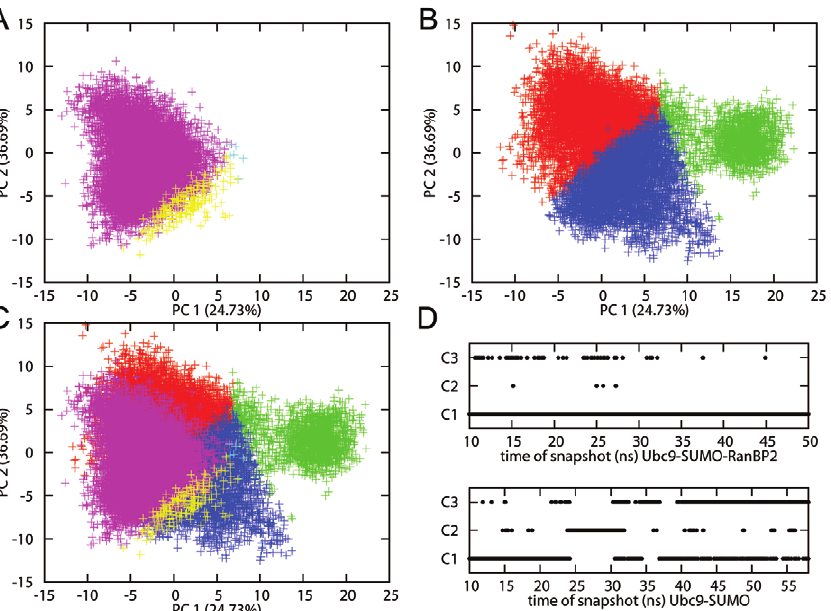
Figure 4. Projection of Ubc9 conformations on principal components. The PCs are given in A˚. The proportion of all trajectory accounted for by the PCs up to current PC is given in parenthesis on each axis. (A–C) x-axis is PC1, y-axis PC2. (A) Ubc9 conformations from the Ubc9-SUMO-RanBP2 simulation, projected on PC1 and PC2. Members of cluster 1 in magenta, cluster 2 in cyan, cluster 3 in yellow. (B) Ubc9 conformations from Ubc9- SUMO simulation, projected on PC1 and PC2. Members of cluster 1 in red, cluster 2 in green, cluster 3 in blue. (C) Merged plot of A and B, with same color coding. (D) The distribution of cluster members in time, x-axis time, y-axis cluster number. Upper lane is Ubc9-SUMO-RanBP2, and lower lane is Ubc9-SUMO.